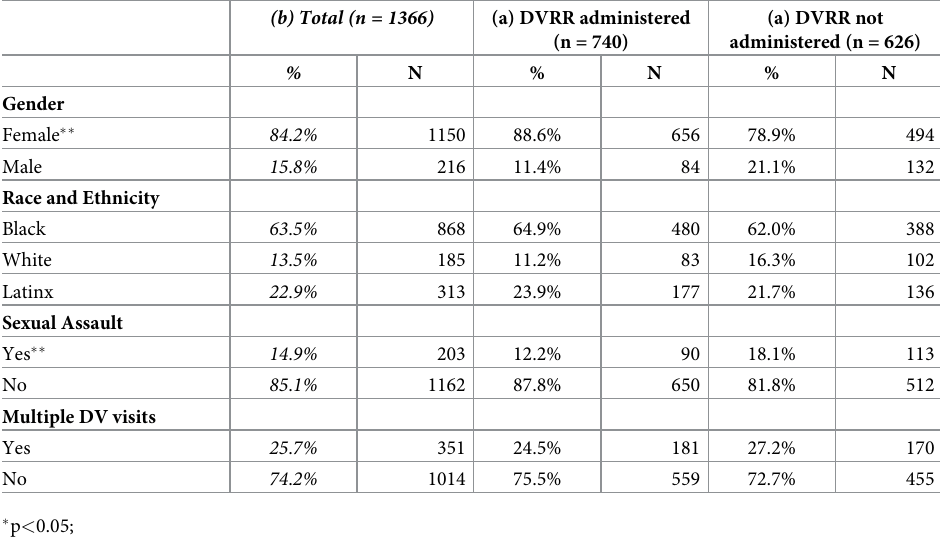
Table 1. Descriptive characteristics of study ED